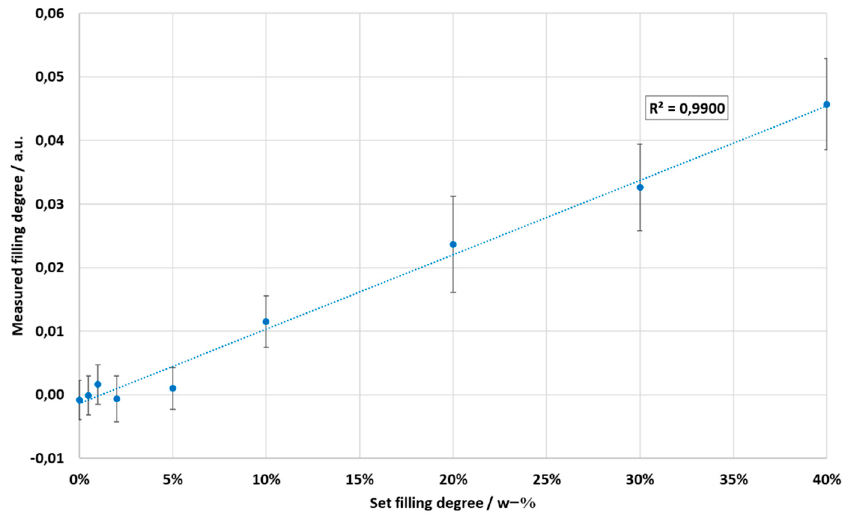
Figure 6. Result of the photometric measurements. The data points are based on all individually calculated filling degrees of the analyzed double emulsion droplets. A high linearity with a Pearson coefficient of R 2 = 0.9900 is shown.